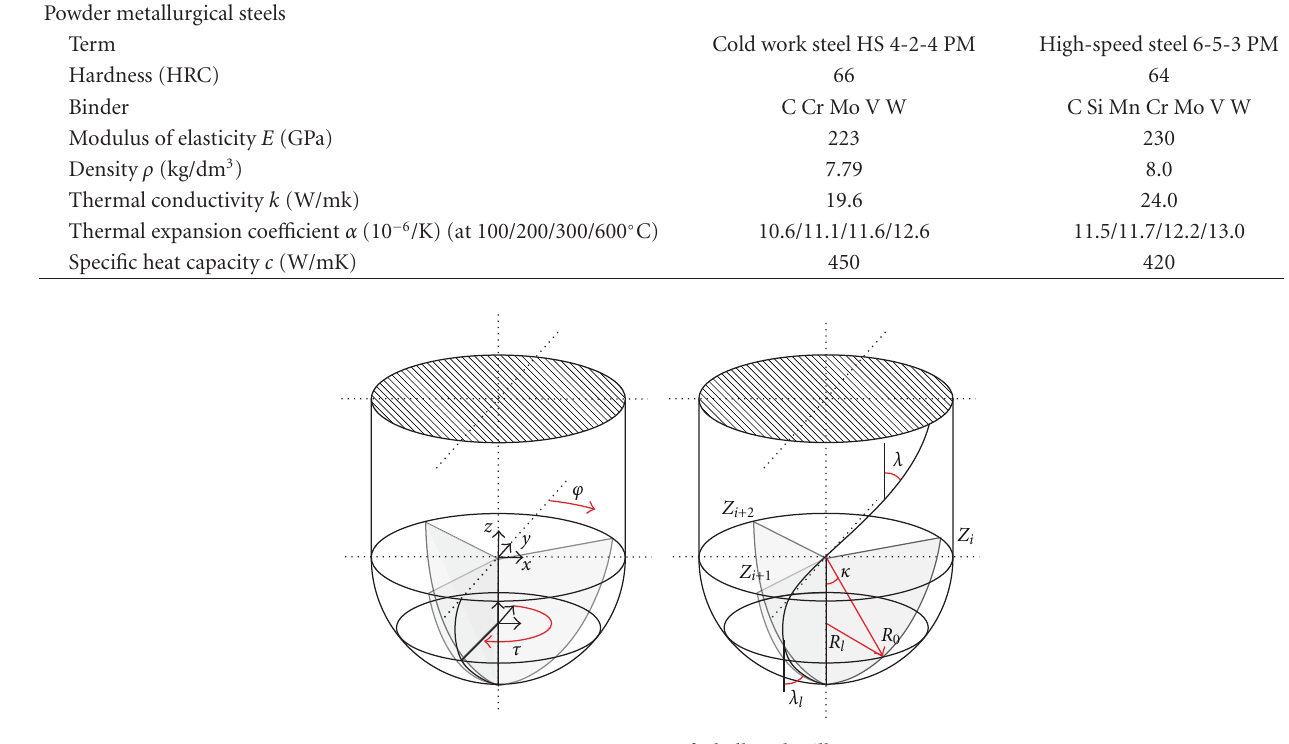
Figure 3: Geometry of a ball-end mill.